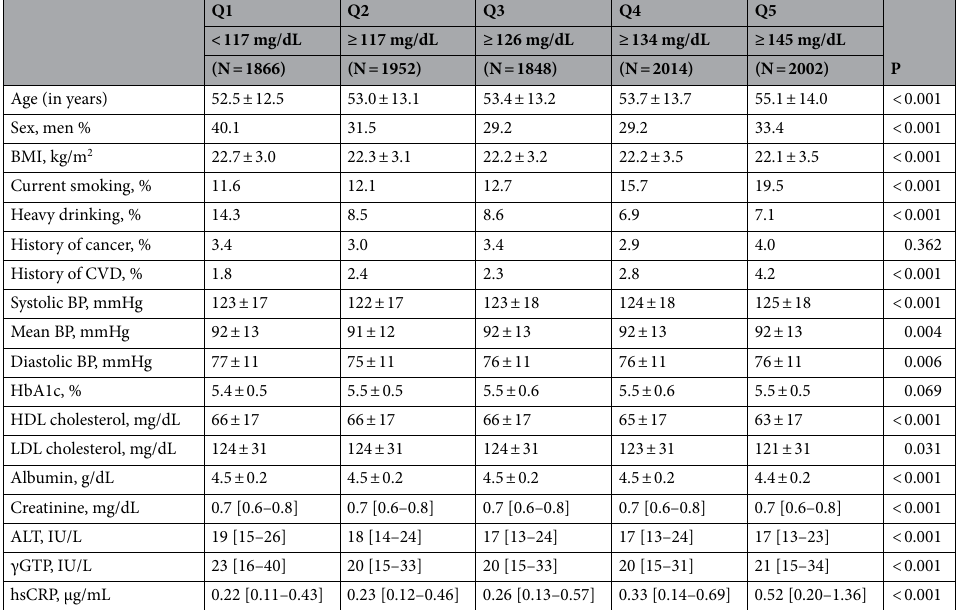
Table 1. Baseline clinical characteristics of study participants by AAT level quintile (N = 9682). Values are provided as the mean ± standard deviation, median [interquartile range], or frequency. Numbers of study participants in each quintile are shown in parentheses. Statistical significance was assessed by analysis of variance, Kruskal–Wallis test, or a Chi-squared test. Cardiovascular disease (CVD) includes symptomatic stroke, angina pectoris, and myocardial infarction. AAT α1-antitrypsin, BMI body mass index, BP blood pressure, HbA1c hemoglobin A1c, HDL high-density lipoprotein, LDL low-density lipoprotein, ALT alanine aminotransferase, γGTP gamma-glutamyltransferase, hsCRP high-sensitivity C-reactive